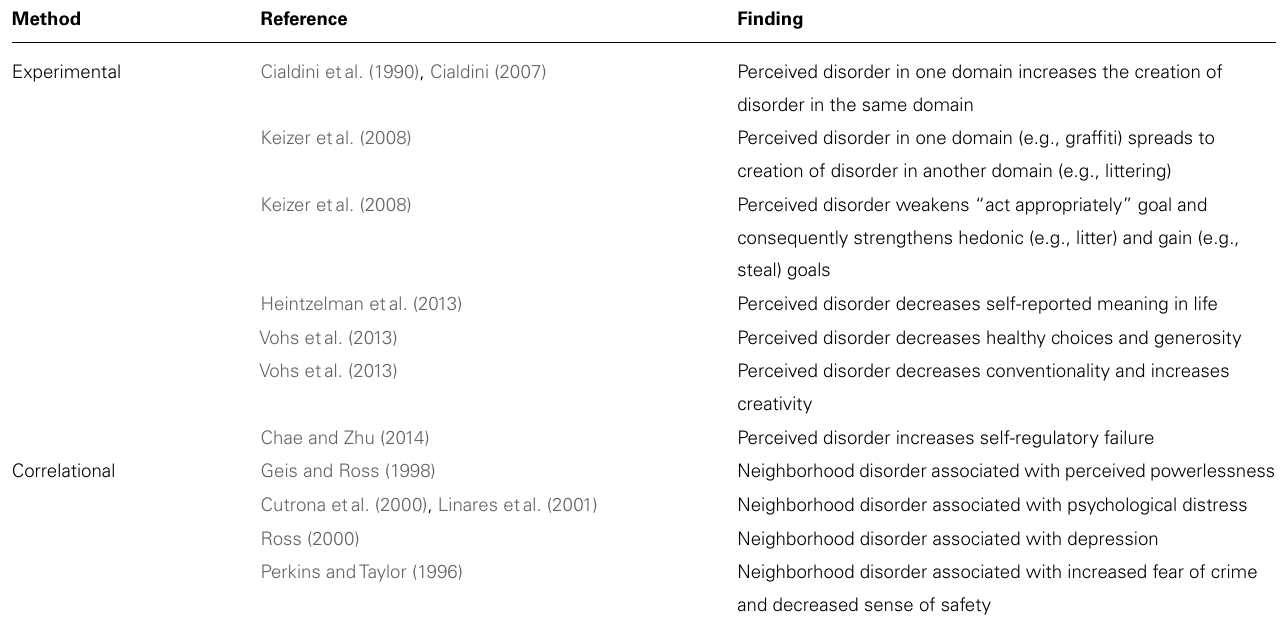
Table 1 | Select experimental and correlational findings on the psychological consequences of